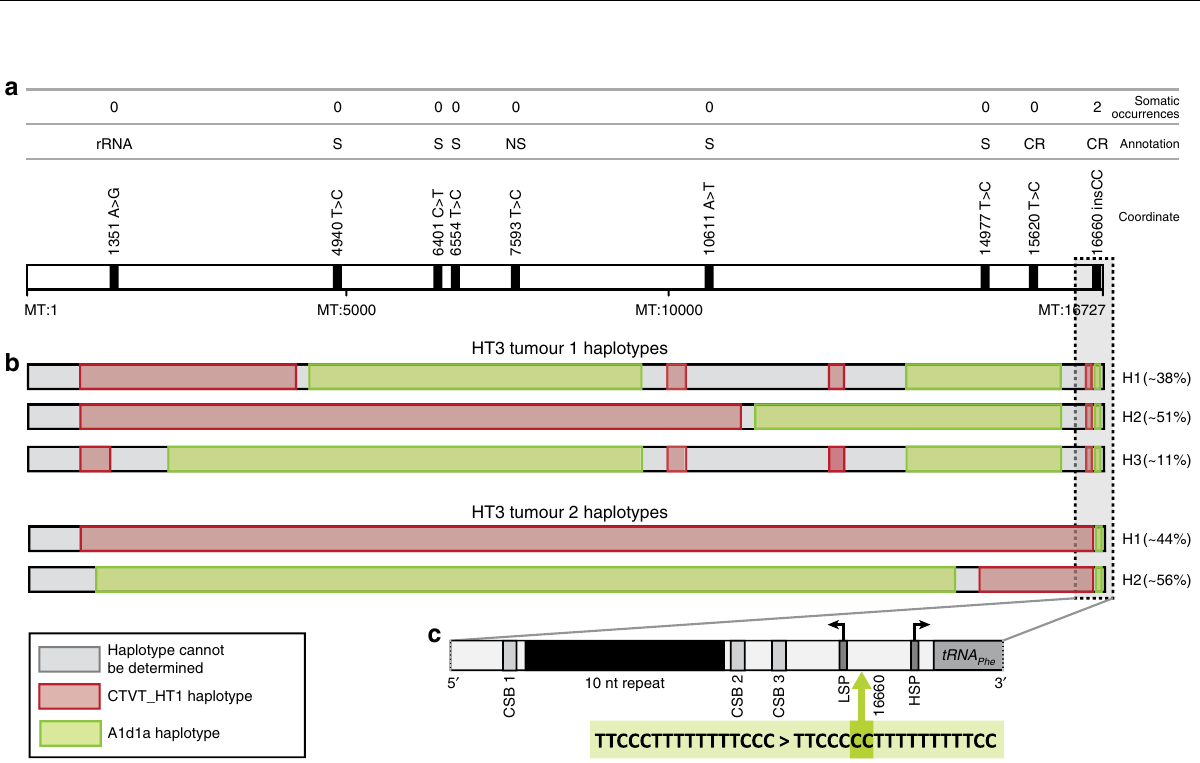
Fig. 2 Genetic features of the A1d1a haplotype. a Genetic variants unique to the A1d1a haplotype (and in some cases shared with the related A1d1 haplotype, Supplementary Data 5) relative to 16 other dog haplotype groups. Number of somatic occurrences on other non-A1d1a CTVT mtDNA backgrounds is indicated above each variant. Variants within protein-coding genes are annotated as synonymous (S) or non-synonymous (NS), and other variants are annotated as occurring within ribosomal RNA (rRNA) or the control region (CR). MtDNA (MT) genome coordinates are indicated. b MtDNA haplotypes detected using long-read sequencing in the two tumours (labelled tumour 1 and tumour 2) belonging to the HT3 group, in which A1d1a and CTVT_HT1 have undergone recombination, with a heteroplasmic mixture of recombination products present in each tumour. The region fi xed in all haplotypes in both tumours is indicated with a dotted box. The estimated frequency of each recombinant haplotype (H) within the two tumours ’ CTVT cell mtDNA population is shown. c 16660insCC sequence context and position relative to control region features. Conserved sequence blocks (CSB) 1 – 3 are marked, together with the light strand promoter (LSP), heavy strand promoter (HSP) and a ten-nucleotide (nt) repeat block. 16660insCC co-occurs in A1d1a with 16672C>T, a polymorphism present on several canine